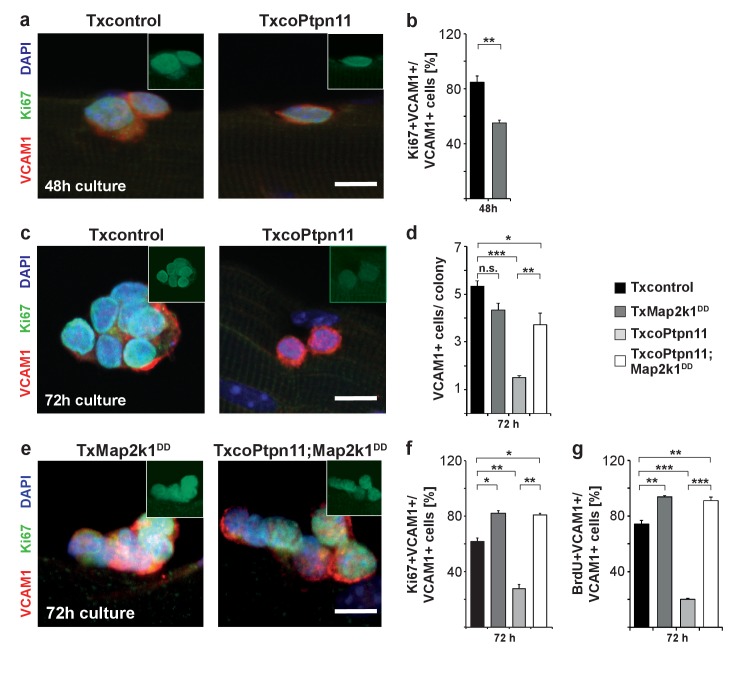
Activation of Mapk/Erk1/2 signaling rescues proliferation of Ptpn11-mutant satellite cells.Fibers from adult Txcontrol and TxcoPtpn11 mice were cultured for the indicated times, and analyzed for VCAM1 (red) and Ki67 (green) protein; the inset depicts Ki67 staining (green). Nuclei were counterstained with DAPI (blue). (b) Quantification of VCAM1+ cells co-expressing Ki67. (c,e) Staining of satellite cells for VCAM1 (red), Ki67 (green) and DAPI (blue); fibers were isolated from (c) Txcontrol and TxcoPtpn11 mutant mice and (e) from TxMap2k1DD and TxcoPtpn11;Map2k1DD mice. The insets depict Ki67 staining (green). (d) Quantification of VCAM1+ cells/colony. (f,g) Quantification of VCAM1+ cell co-expressing Ki67 (f) or incorporating BrdU (g). n.s. = not significant, *p<0.05, **p<0.01, ***p<0.001. Error bars show S.E.M. Scale bar: 10 µm.